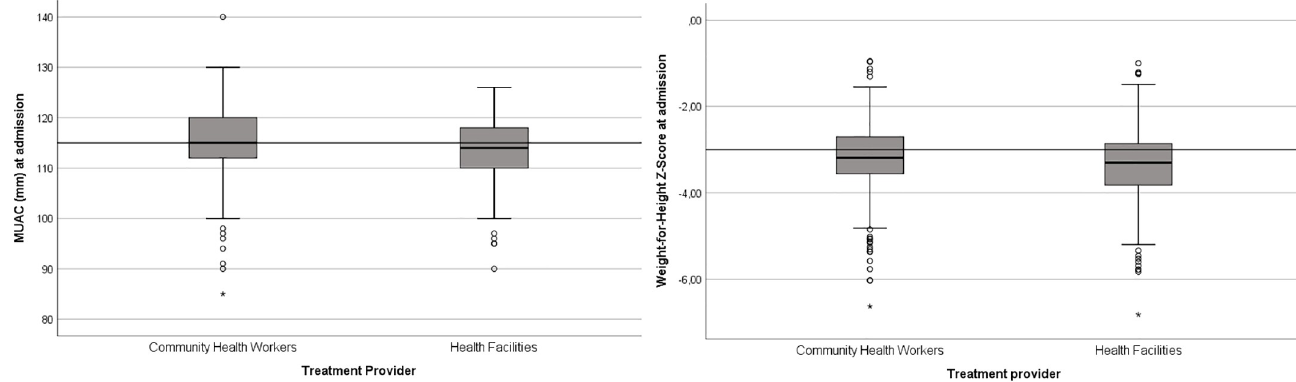
Fig 1. Anthropometric measurements of the children at admission according to the two models of outpatient treatment. Inclusion criteria for severe acute malnutrition treatment is marked with a discontinuous line.